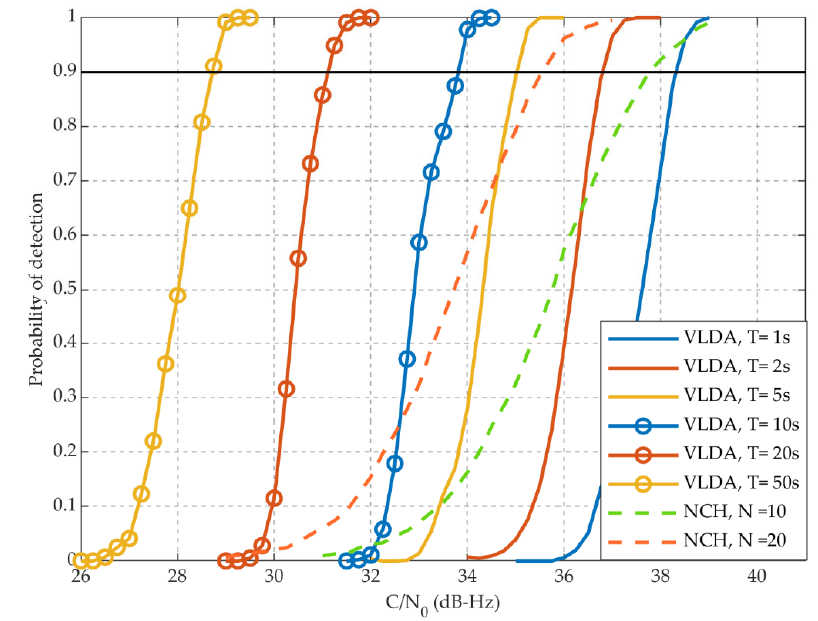
Figure 8. The probability of detection P d under di ff erent methods. ( P f = 10 − 2 ).